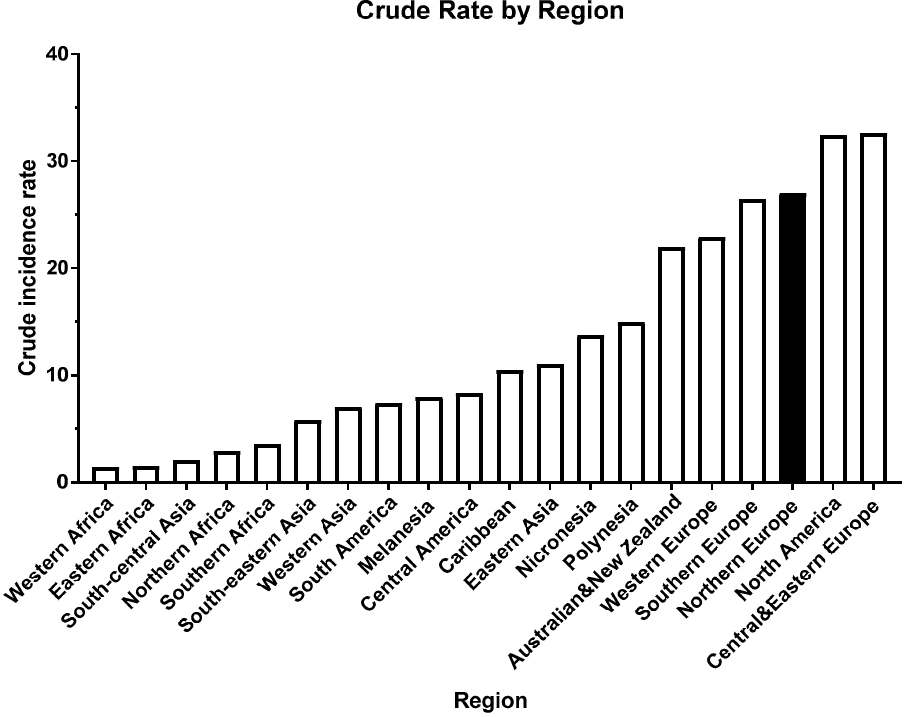
Figure 2. Estimated crude incidence rate for endometrial cancer (all ages; 0–85+) in 2018, based on different regions of the world. Data are shown from lowest incidence rate to highest incidence rates with Northern Europe highlighted with the solid bar. Adapted from [40].